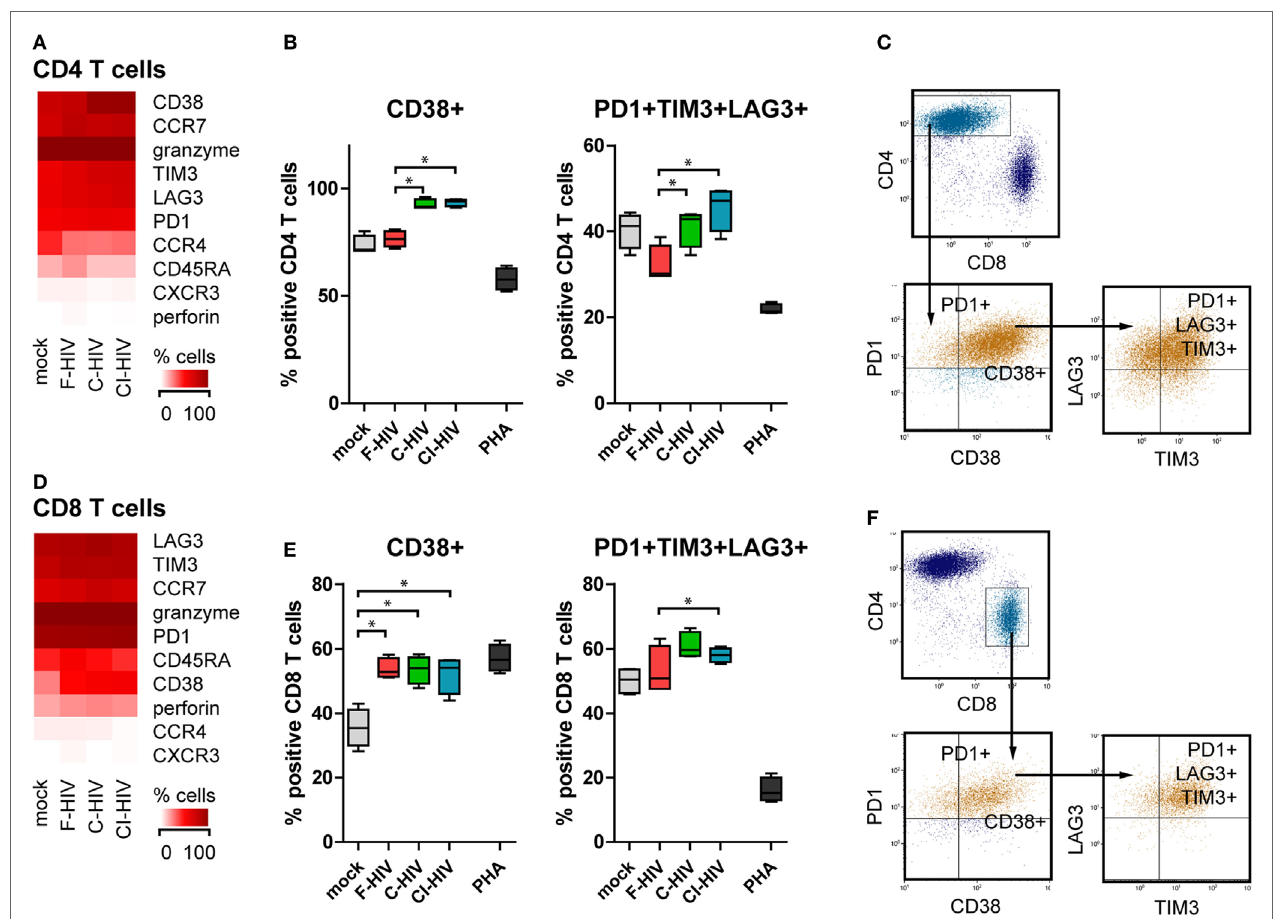
FigUre 8 | Expression of immune checkpoint factors on the CD4 and CD8 T cells activated by CD3 and CD28 ligation and supernatants from the natural killer (NK)–dendritic cell (DC) cross talk assay. DCs and NK cells from the same donor were exposed to 1 μ g/ml F-HIV, complement-opsonized HIV (C-HIV), CI-HIV, PHA, or mock treated for 24 h. The experiment was replicated four times using cells derived from four different donors. Allogeneic T cells were stimulated by CD3/CD28 ligation in the presence of supernatants from these cultures. (a,D) The CD4 T cell (a) and CD8 T cell (D) phenotype generated was assessed using flow cytometry. Heat maps of the percentage of CD4 cells or CD8 T cells positive for phenotypic markers was created. The number of CD4 T cells (B) or CD8 T cells (e) positive for CD38, and the number of cells coexpressing PD-1, TIM-3, and LAG-3 were evaluated. (c,F) Gating strategy for flow cytometry analysis of a representative sample. Boxplots show mean with Tukey error bars. One-way ANOVA followed by a Bonferroni posttest was used to test for statistical significance (* p < 0.05, N =